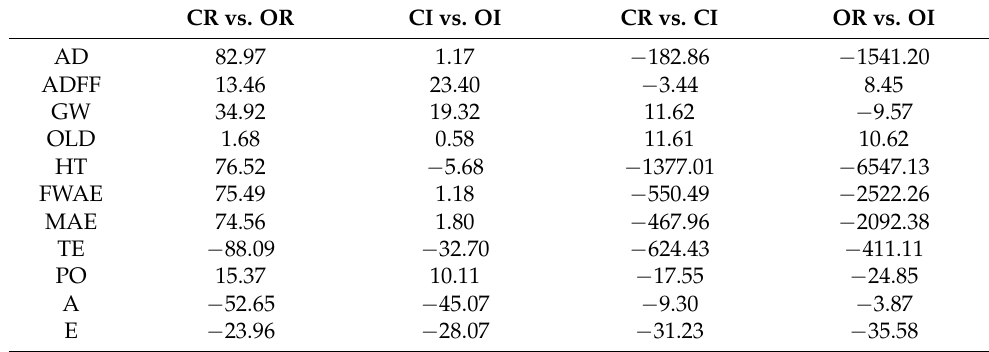
Table 10. Relative differences between the different types of vineyard.